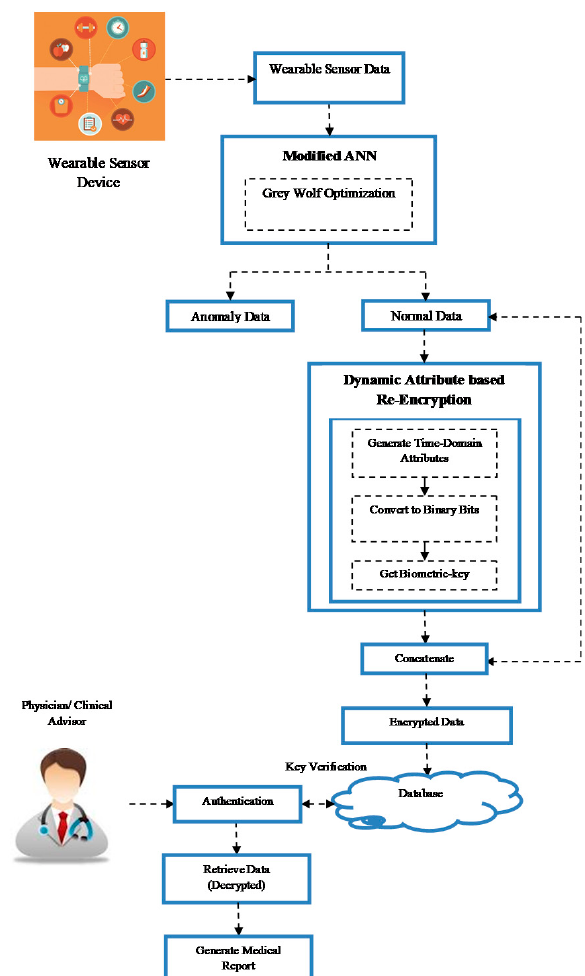
Figure 1. The structure of the proposed privacy preservation model for edge consumer electronics